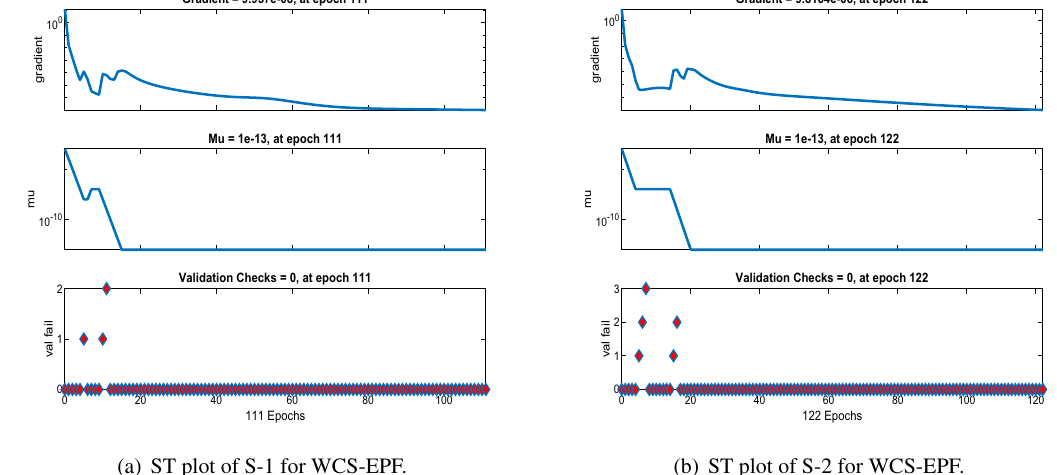
(b) ST plot of S-2 for WCS-EPF.